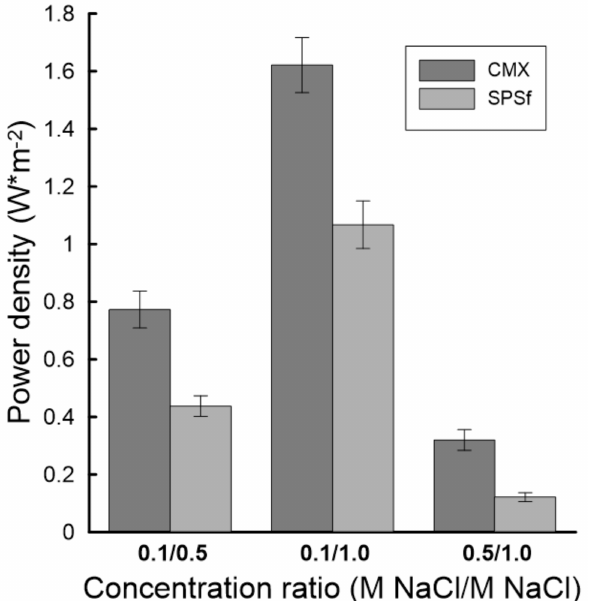
Figure 14. Theoretical power density of the CMX and sPSf membranes exposed to different NaCl solution